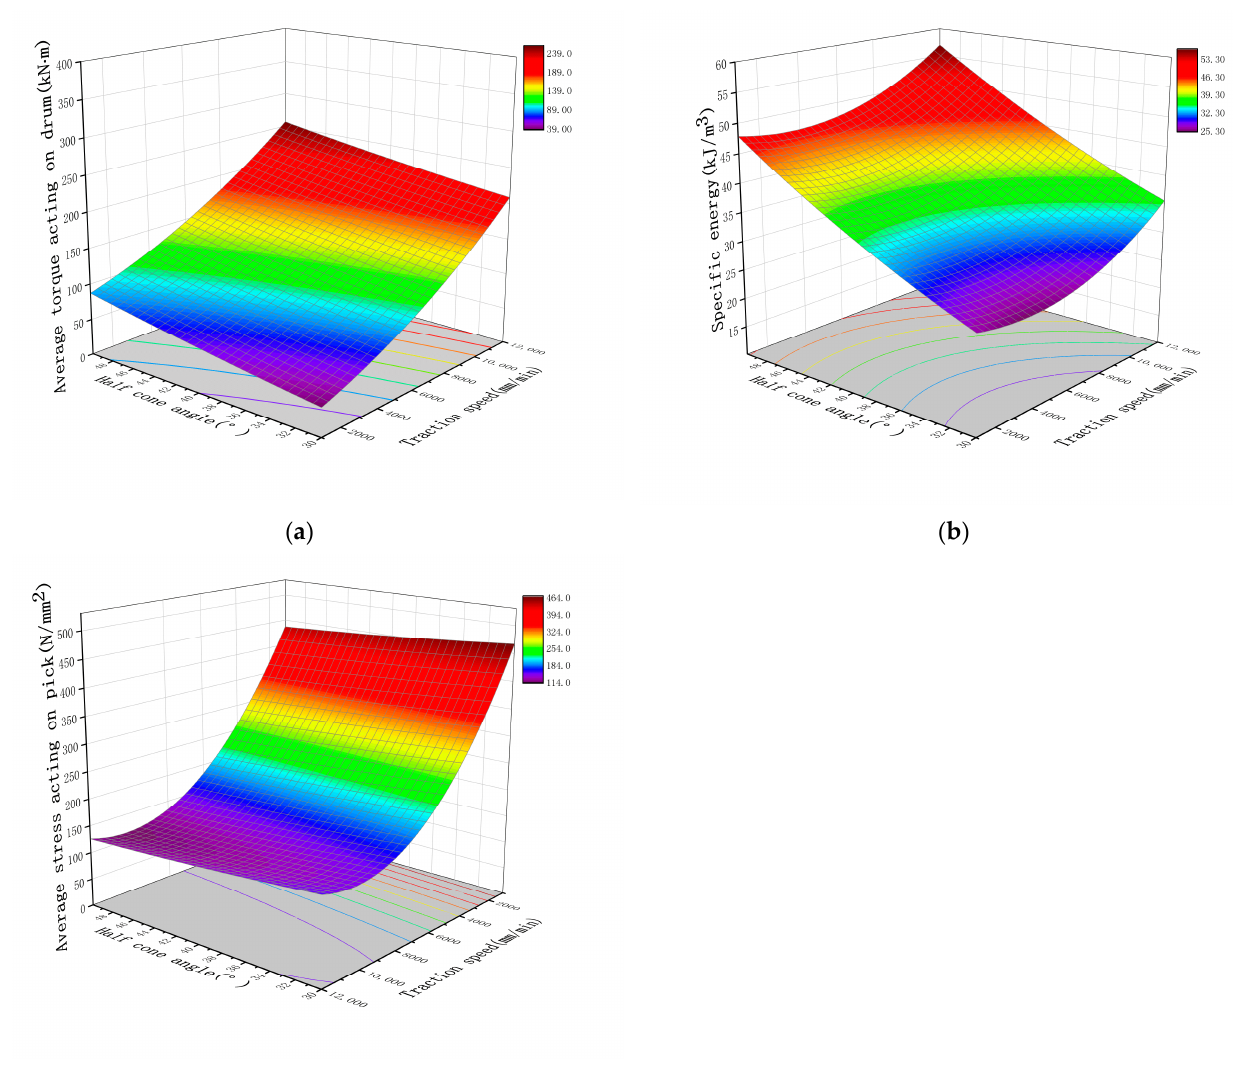
Figure 3. Influence of Φ and v q on optimization objectives. ( a ) Influence of Φ and v q on M ; ( b ) influence of Φ and v q on H w ; ( c ) influence of Φ and v q on σ